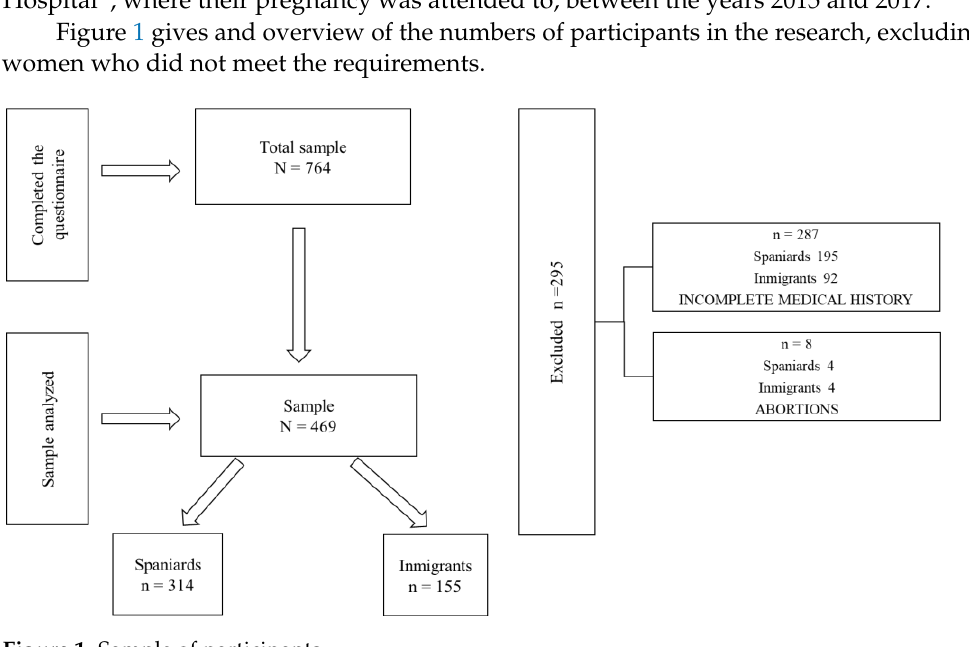
Figure 1. Sample of participants.